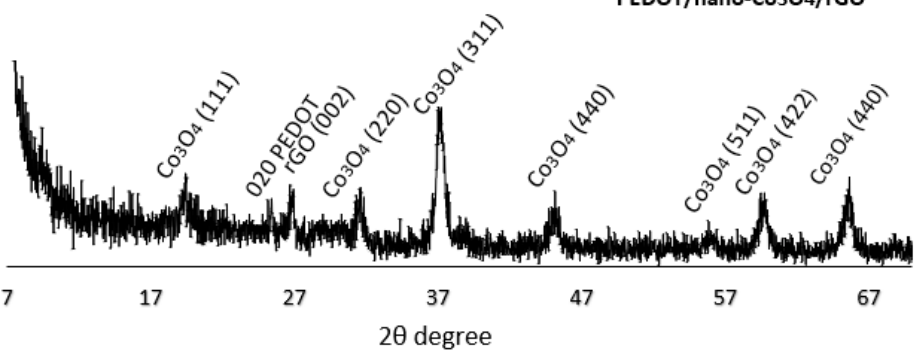
Figure 5. Powder XRD of PEDOT/nano Co 3 O 4 /rGO.